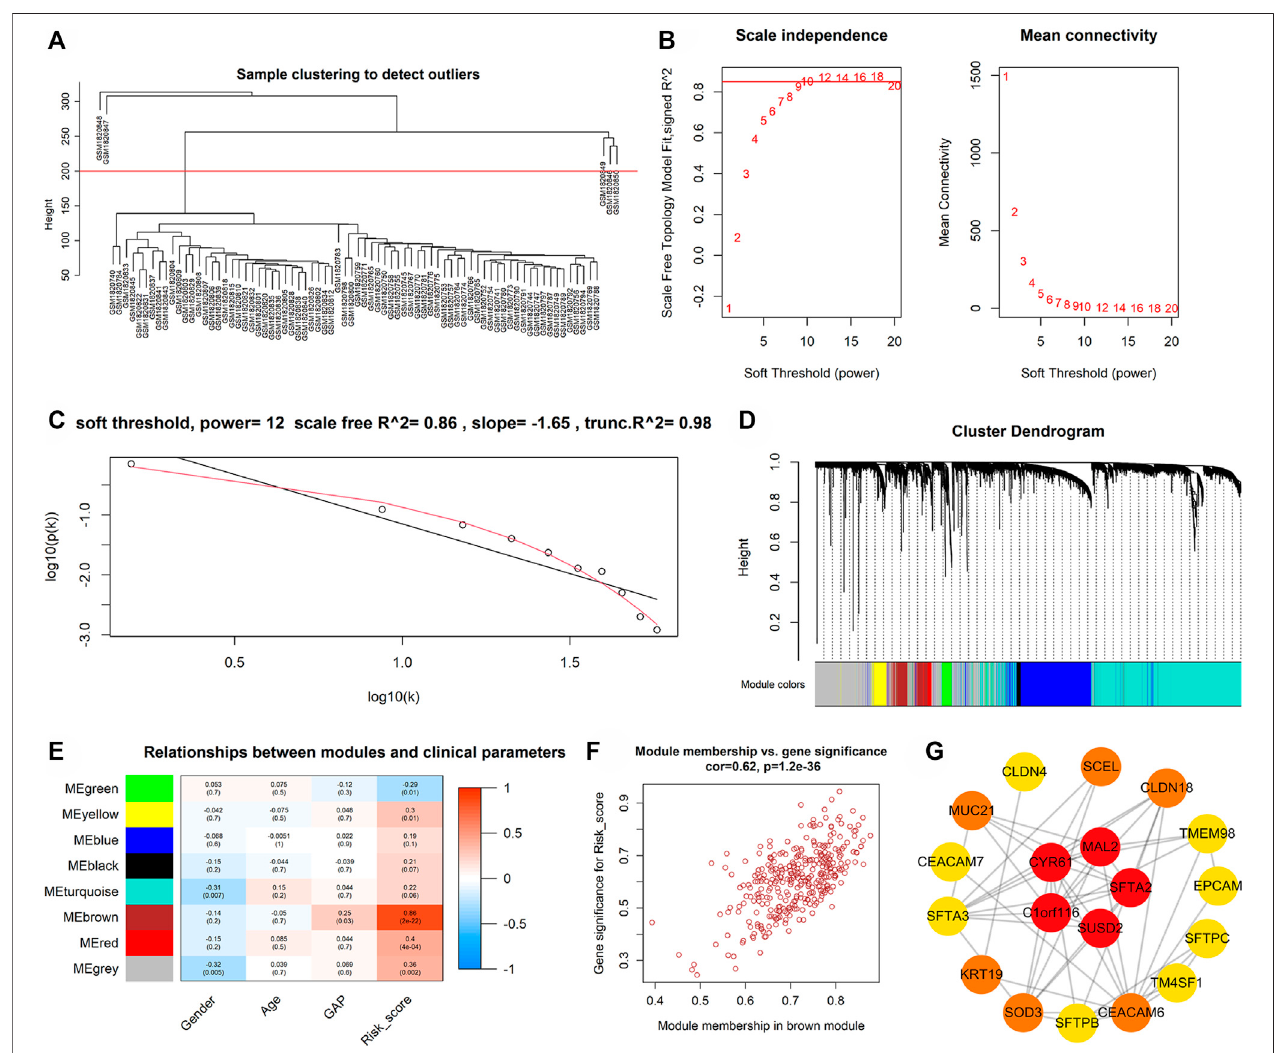
FIGURE9| Thepossiblehubgenesofm7GPSinIPFbasedonthediscoverycohort. (A) Theclusteringtreediagramindicatesthat fi vesamples(abovetheredline) with distinct outliers should be excluded; the remaining 74 samples (below the red line) were utilized for subsequent analysis. (B,C) The soft threshold was 12 when the optimal scale-free R 2 equaled 0.86. (D – E) Eight modules were determined in hierarchical clustering, of which the “ brown ” module had the strongest correlation with the m7GPS risk score by Pearson correlation coef fi cient. (F) A signi fi cant positive correlation between gene signi fi cance of risk score and module membership in the “ brown ” module. (G) Five genes (CYR61, C1ORF116, MAL2, SFTA2, and SUSD2) were hub genes of the “ brown ” module; the network was constructed in Cytoscape with the “ degree ” algorithm. In Cytoscape, the visualization network was constructed based on the top 100 genes (rank by the weight values) of the “ brown ” module; genes not in the most extensive network are not